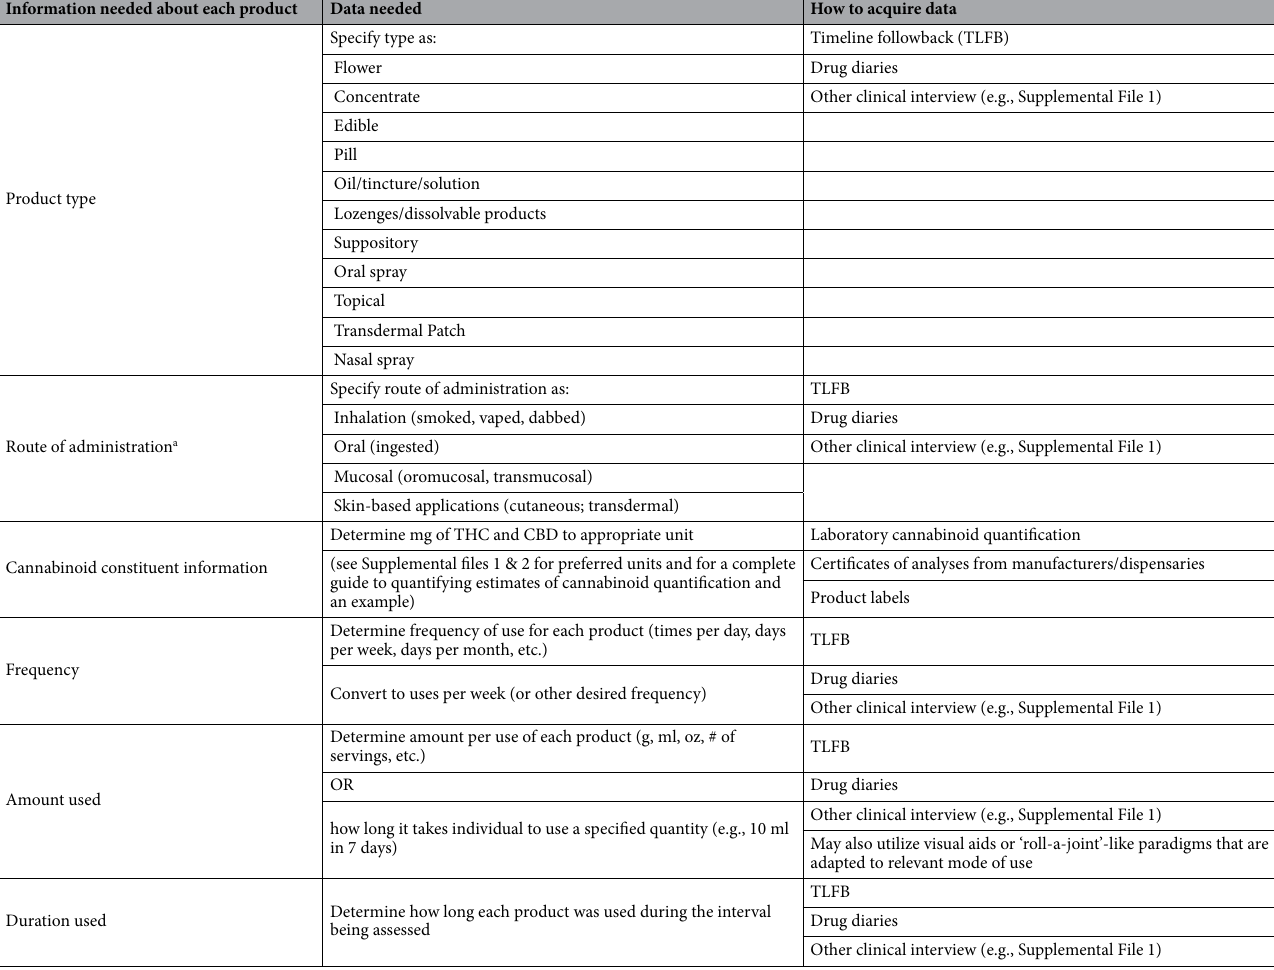
Table 1. Information about key variables for cannabinoid calculations. CannaCount requires acquisition of data for several key variables; the specific information needed for each variable are provided along